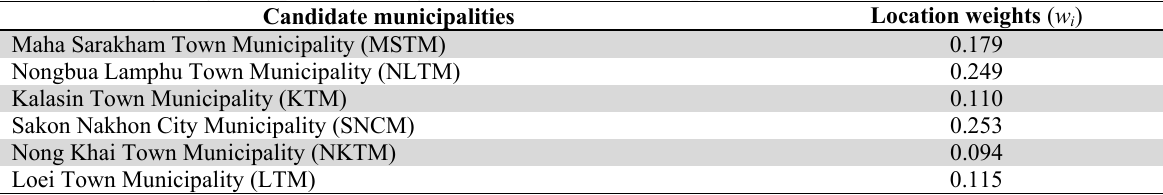
Location weights/global priority weights of candidate municipalities